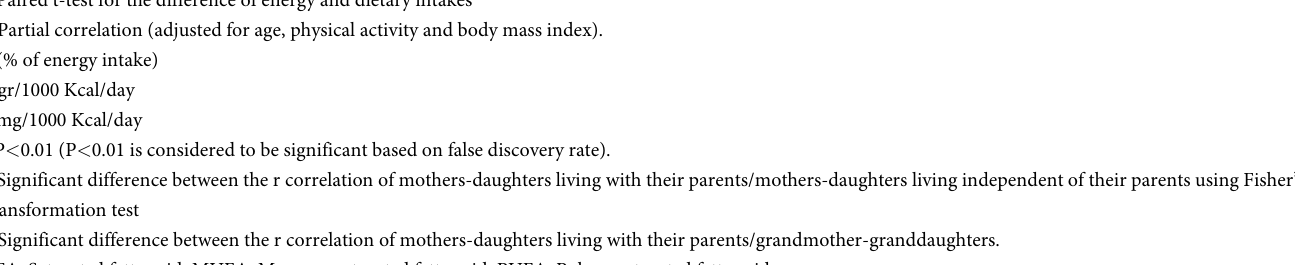
a Paired t-test for the difference of energy and dietary intakes b Partial correlation (adjusted for age, physical activity and body mass index).